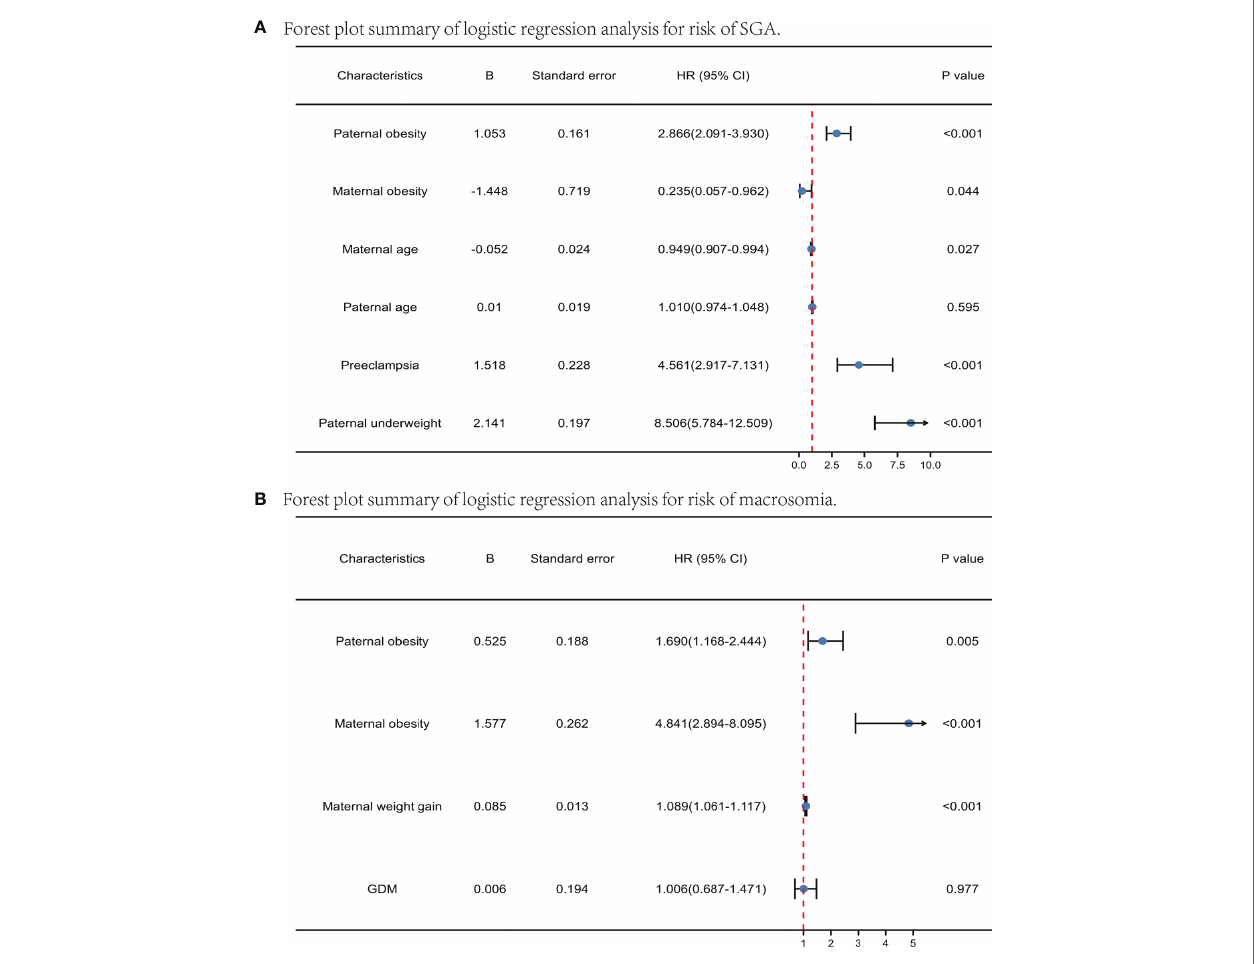
FIGURE 2 | Forest plot summary of logistic regression analysis for risk of SGA and macrosomia. Predictors of SGA (A) and macrosomia (B) pregravid and before pregnancy. Data were presented as odds ratio per standard deviation change in the indicated